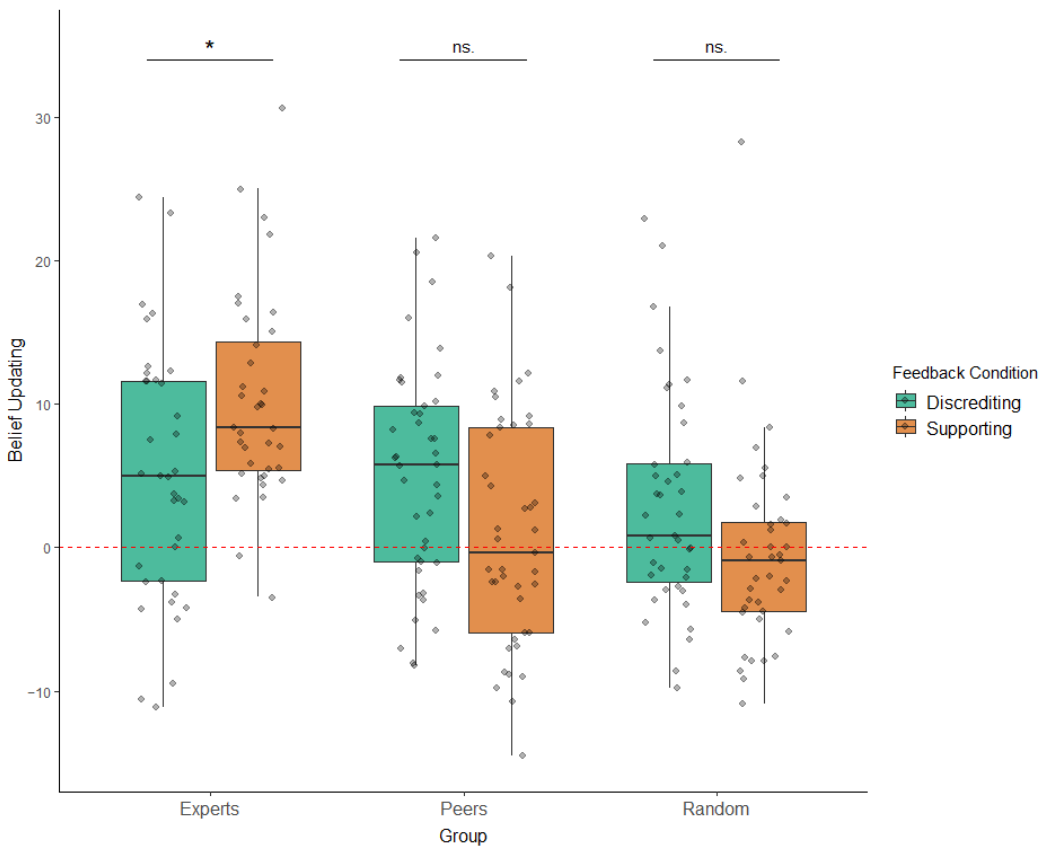
Figure 2. Differences in average belief updating between groups ( x -axis) and conditions (colors). Dashed red line denotes “no update” (0). Jittered points represent individual averages. Color-blind friendly palette. Statistical significance codes: * p < 0.05 (Bonferroni-corrected).